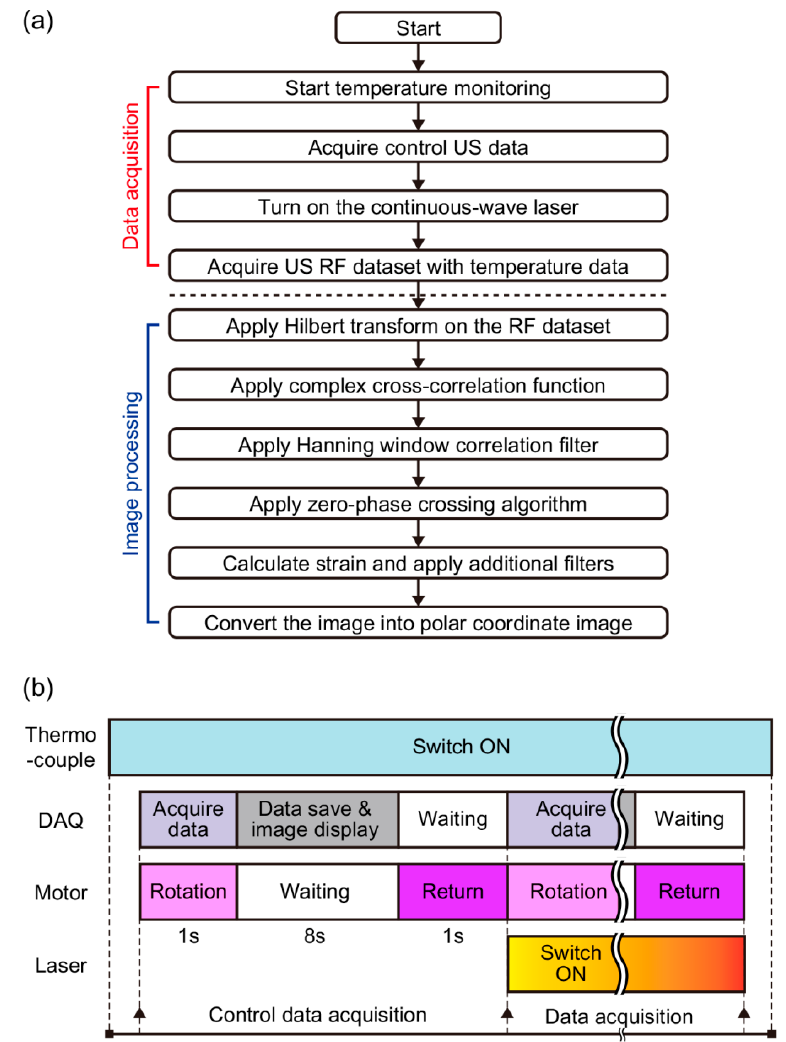
Figure 2. ( a ) A block diagram of data acquisition and image processing part for intravascular photothermal strain imaging. ( b ) Timing diagrams of thermocouple, data acquisition system (DAQ), rotary stage motor, and laser operation. US, ultrasound; RF, radio-frequency.